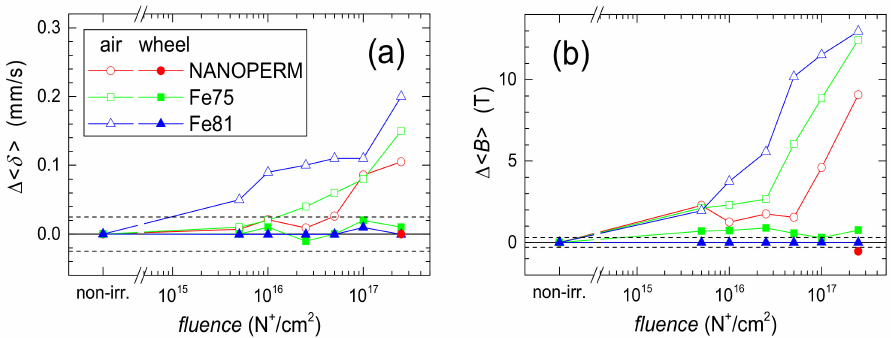
Figure 18. Differences of parameters derived from CEMS spectra of Fe 76 Mo 8 Cu 1 B 15 (NANOPERM- type, red circles), 57 Fe 75 Mo 8 Cu 1 B 16 (Fe75, green squares), and 57 Fe 81 Mo 8 Cu 1 B 10 (Fe81, blue triangles) amorphous metallic alloys irradiated by 130 keV N + ions plotted against the ion fluence: ( a ) Average isomer shift, ∆ (cid:104) δ (cid:105) ; ( b ) average hyperfine magnetic field, ∆ (cid:104) B (cid:105) . Open and solid symbols correspond to CEMS spectra taken from air and wheel sides of the ribbons, respectively. Solid lines are only guides for the eye, dashed lines represent the error